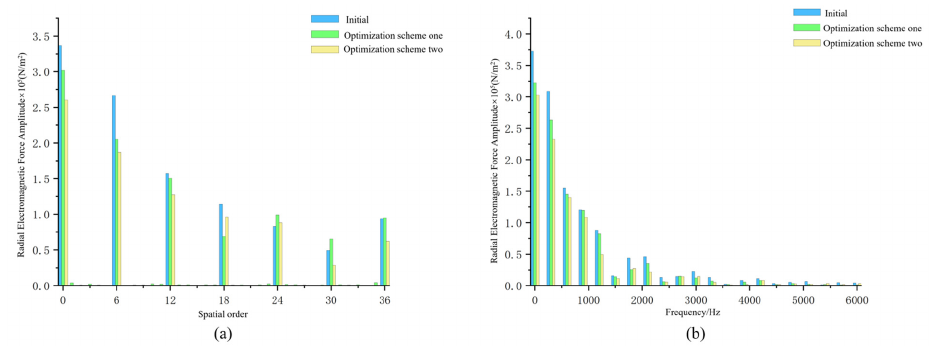
Figure 7. ( a ) Radial electromagnetic force distribution with spatial order; ( b ) radial electromagnetic force distribution with time–frequency at a point on the stator tooth end. force distribution with time–frequency at a point on the stator tooth end.